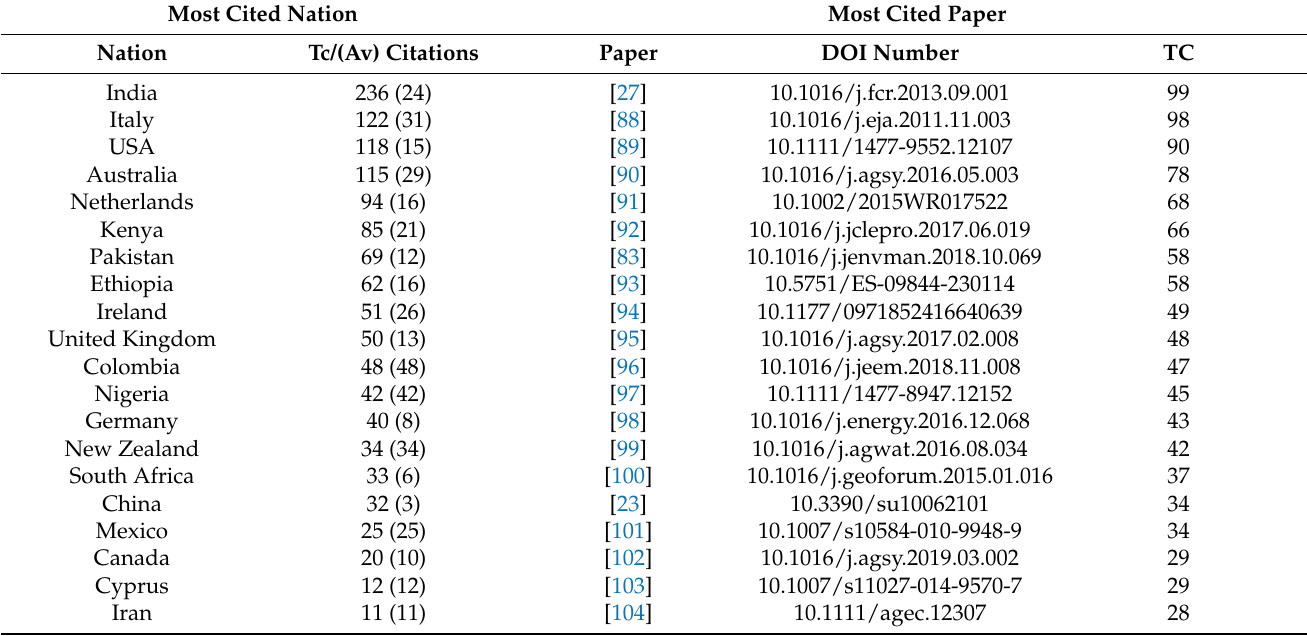
Table 6. Top twenty most cited nations and top twenty most cited published papers within the period